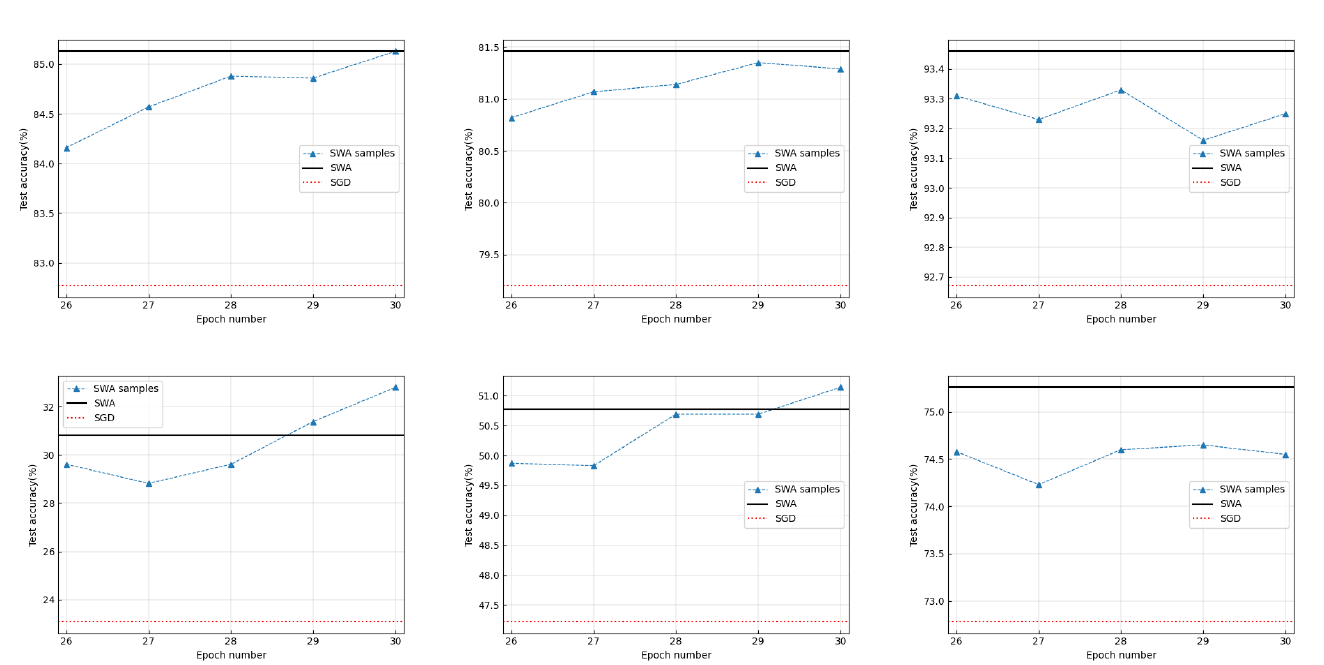
Figure 2. Ablation study on the CHC learning-rate schedule and the weight-averaging operation for DNNs that did not converge well. The legends are defined in the same way as in Figure 1. The sub- figures in the left/middle/right columns correspond to VGG16/PreResNet-164/WideResNet-28-10. The sub-figures in the top/bottom rows correspond to dataset CIFAR-10/CIFAR-100. 4. Periodic